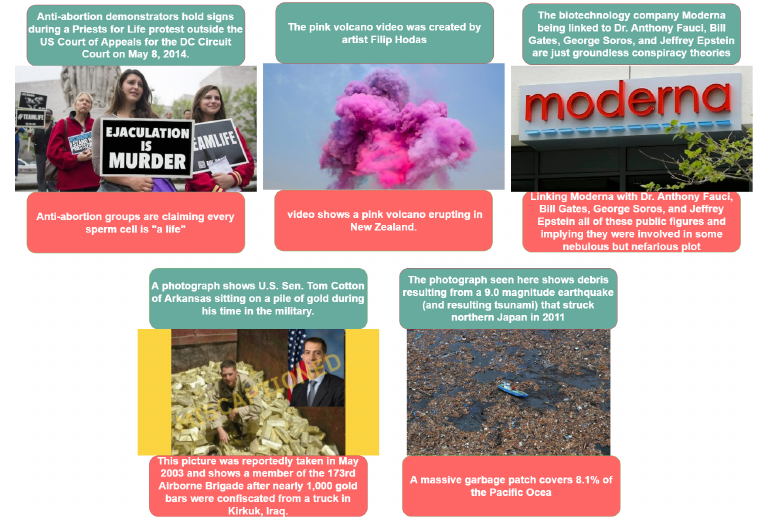
Figure 8. False negative cases. Out-of-context captioned image is classified as